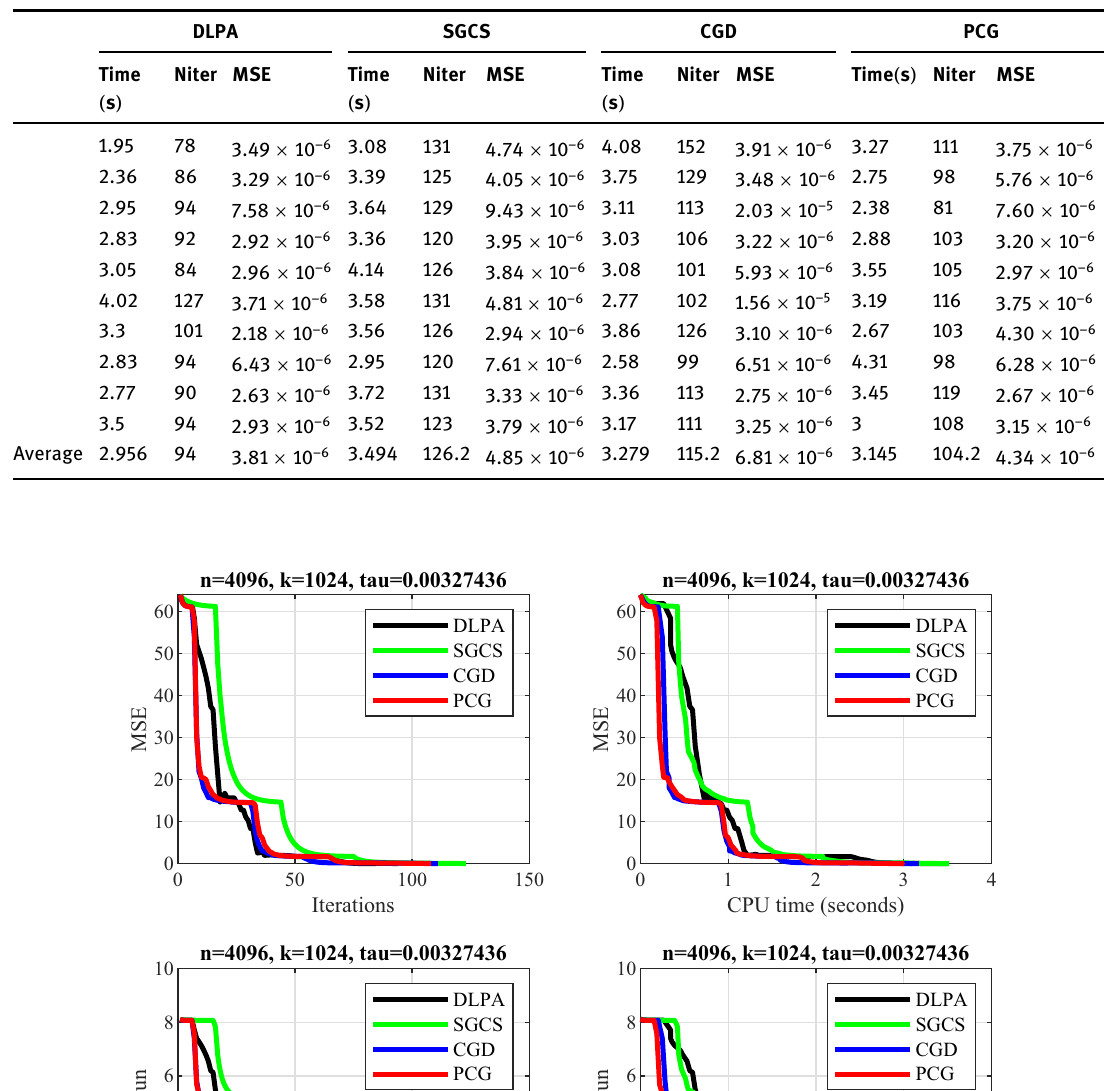
Table 1: Experimental results of sparse signal decoding in compressed sensing problem via DLPA, SGCS, CGD, and PCG algorithms